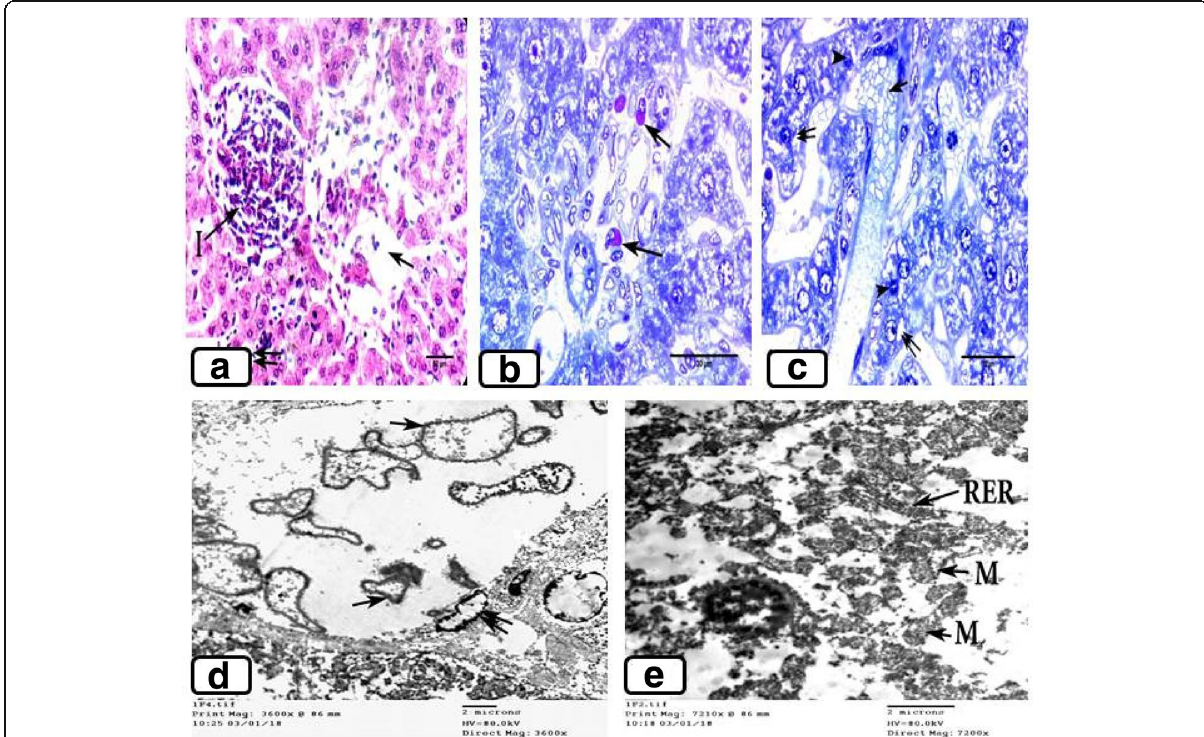
Fig. 4 F2 group liver showing a focal necrotic area ( ↑ ), foci of cellular infiltration around the portal area (I), leucocytic aggregation between liver cells ( ↑↑ ), and vacuolation and degeneration of many hepatocytes (H&E). b Many of mast cells between portal areas ( ↑ ) (toluidine blue stain). c Large dilatation of blood sinusoids filled with deformed RBCs ( ↑ ), highly vacuolated cytoplasm of many hepatocytes ( ↑↑ ), and pyknotic nuclei (arrowhead). Note: deposition of RBCs debris in the wall of blood sinusoids (toluidine blue stain). d Ultrastructure of hepatocytes showing deformed RBCs with thickened their plasma membrane ( ↑ ) and the nuclei of endothelial cell appeared irregular in shape with condensed chromatin ( ↑↑ ). e Ultrastructure of hepatocytes showing destructed mitochondria (M) and fragmented rough endoplasmic reticulum (RER). Note: degenerated